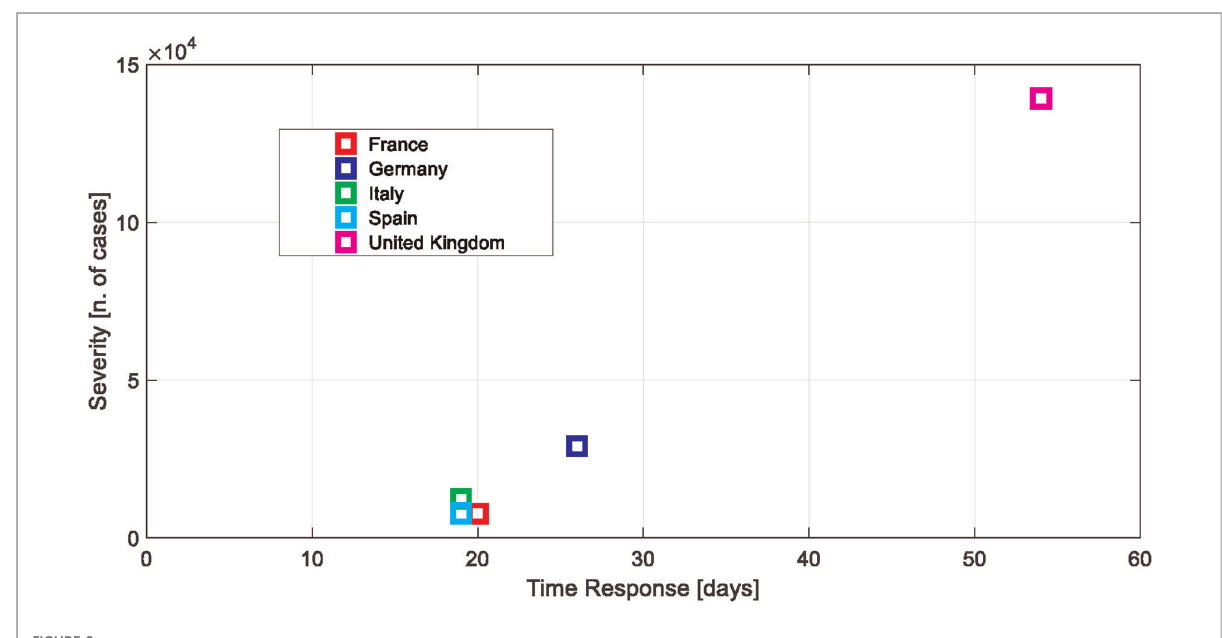
FIGURE 8 Time response vs.